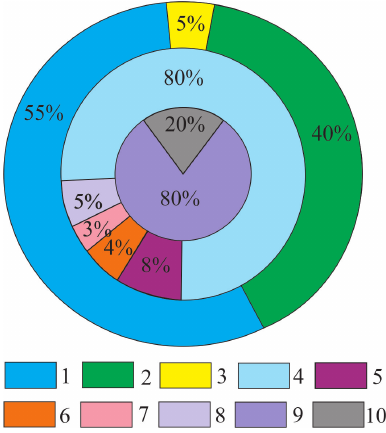
Figure 6. The main typomorphic features of the Nebaibyt river basin gold: 1–3—granulometric composition: 1—<0.2 mm, 2—0.2–0.5 mm, 3—0.5–1 mm; 48—fineness: 4—951‰–999‰ (very high-